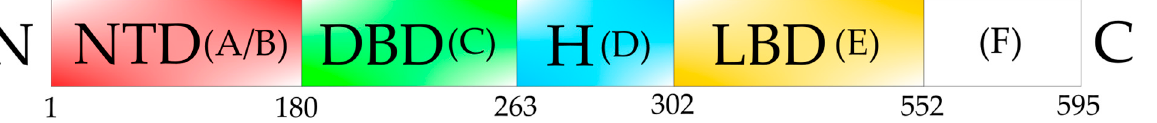
Figure 1. Schematic representation of the human Estrogen Receptor alpha. The NTD domain (N- terminal domain, red, ( A / B )) contains the sub-domains ( A , B ), which are essential for transcriptional activation. DBD domain (DNA-binding domain, green, ( C )) is the specific DNA-binding domain, which binds to the ERE in the gene promoter of ER-target genes. The H region is the flexible hinge domain (blue, ( D )). LBD domain (ligand binding domain, yellow, ( E )) is the specific estrogen binding site, and is required for receptor dimerization, nuclear localization, and transcriptional coactivators/corepressors recruitment. ( F ) domain (white) seems to perform a similar function as the NTD domain. The numbers indicate the amino acid residue positions in the ER.